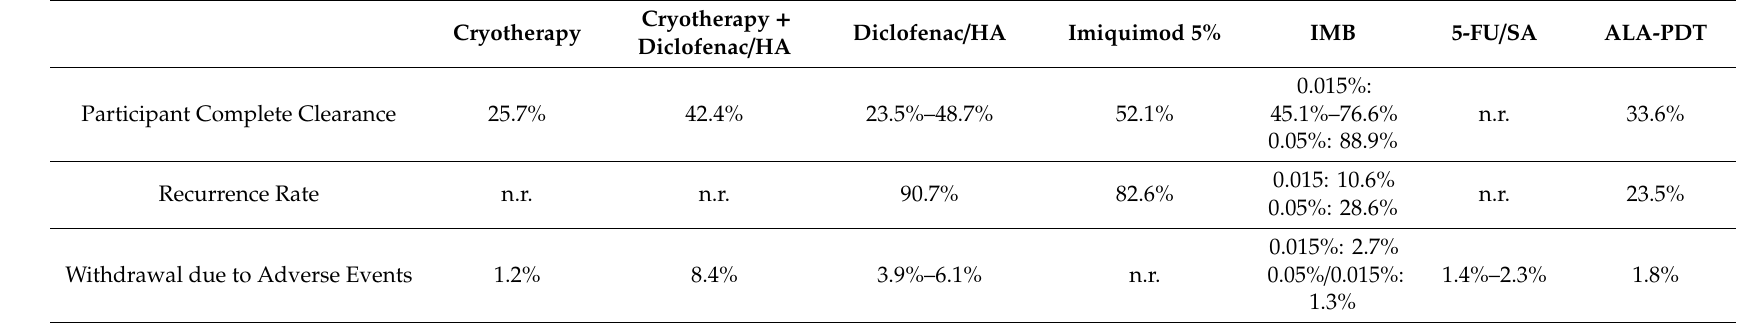
Table 3. Balance sheet comparing the interventions and outcomes at a